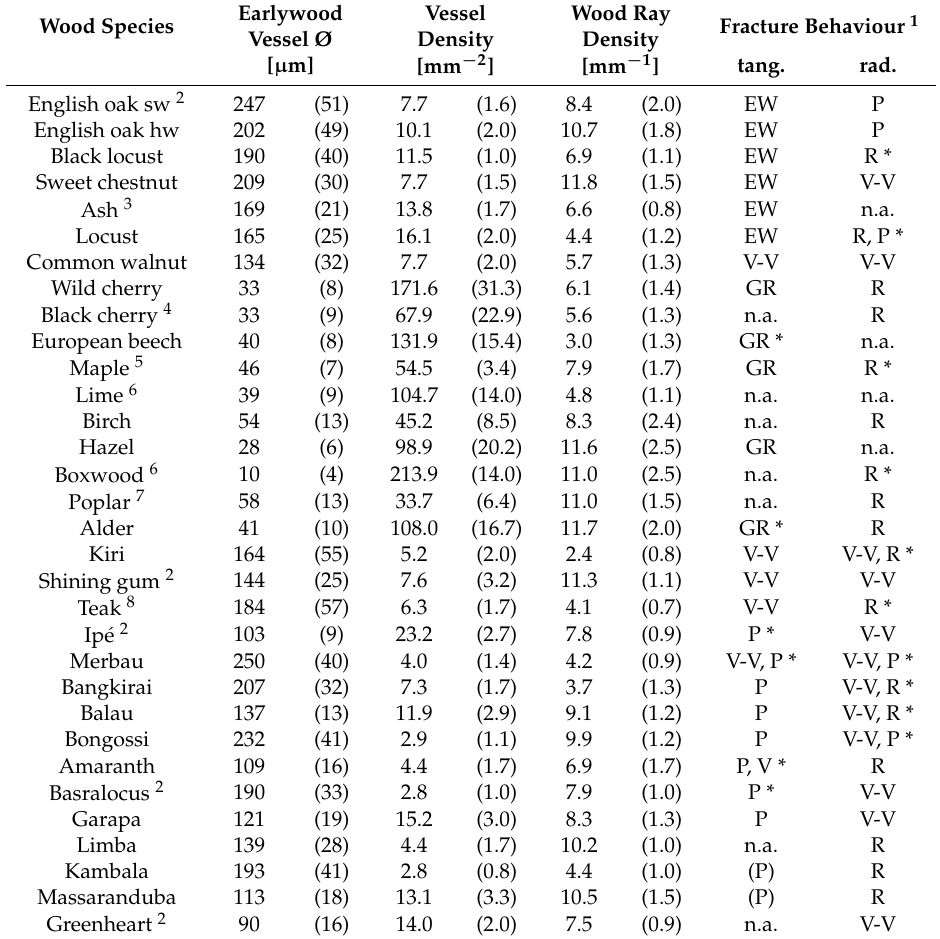
Table 4. The anatomical characteristics (earlywood vessel diameter, vessel density, ray density) and description of fractures during the HEMI-tests of different hardwood species (standard deviation in